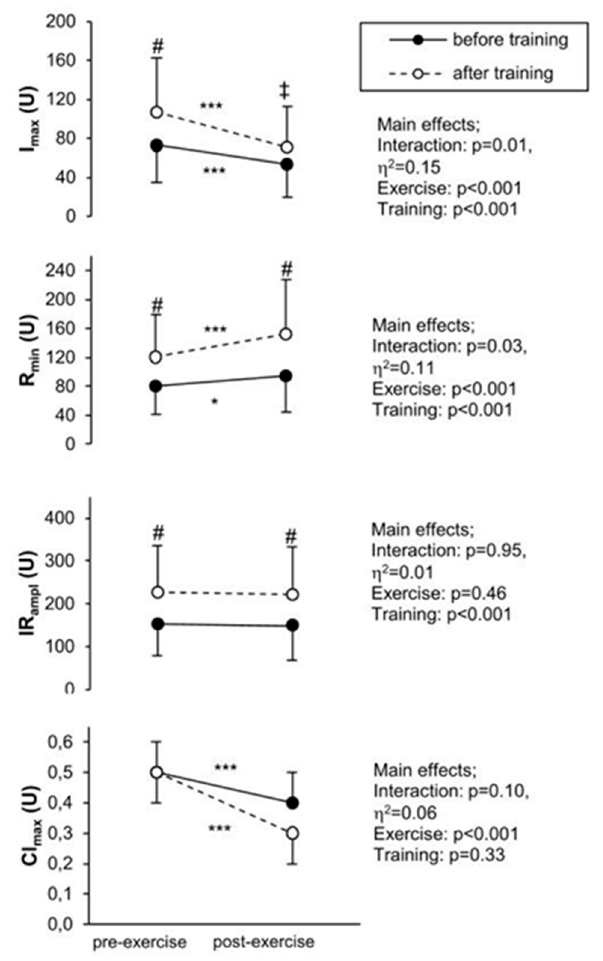
Figure 4. Calculated parameters. Flow Mediated Skin Fluorescence parameters in athletes (N = 41) in two examinations, before and after the cardiopulmonary exercise test. I max —Changes in the net increase in fluorescence over the baseline during ischemia; IR ampl —Changes in the amplitude of fluorescence change during ischemia and reperfusion; R min —Changes in the net reduction in fluorescence below the baseline; CI max – Changes in I max /IR ampl ratio. Values are means (SD). A two-way analysis of variance (relation between exercise and training), post-hoc Scheffe test, significant differences between pre- and post-exercise: *** p < 0.001, ** p < 0.01, * p < 0.05; significant differences between before and after training # p < 0.001, ‡ p < 0.01, § p < 0.05.